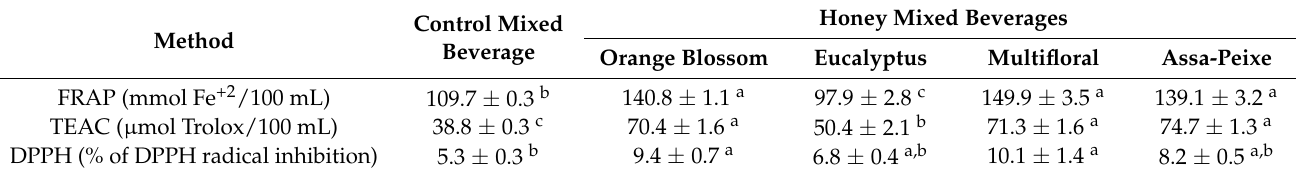
Results are expressed as mean ± standard deviations of three replicates. Different superscript letters in the same row indicate significant differences between mean values (one-way ANOVA followed by Tukey multiple comparisons posthoc test, p <